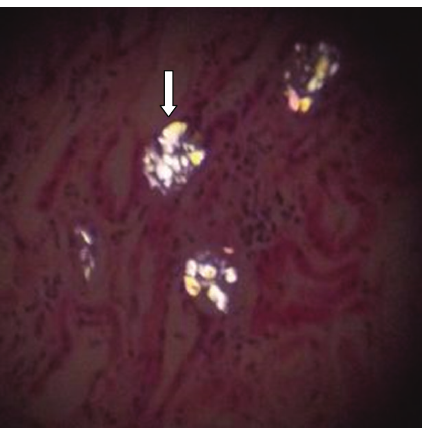
Figure 4: Renal biopsy specimen under polarizing microscope with arrow showing crystals of calcium oxalate.